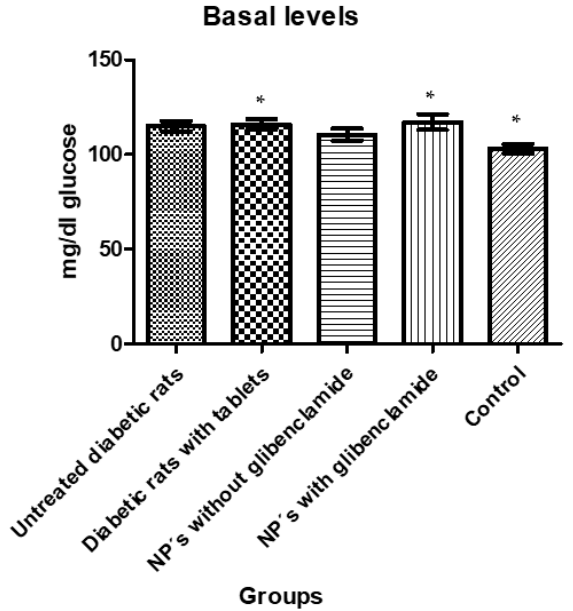
Figure 15. Baselines glucose levels showing significant differences between groups. The asterisks (*) represent a statistically significant difference between groups ( p < 0.05).